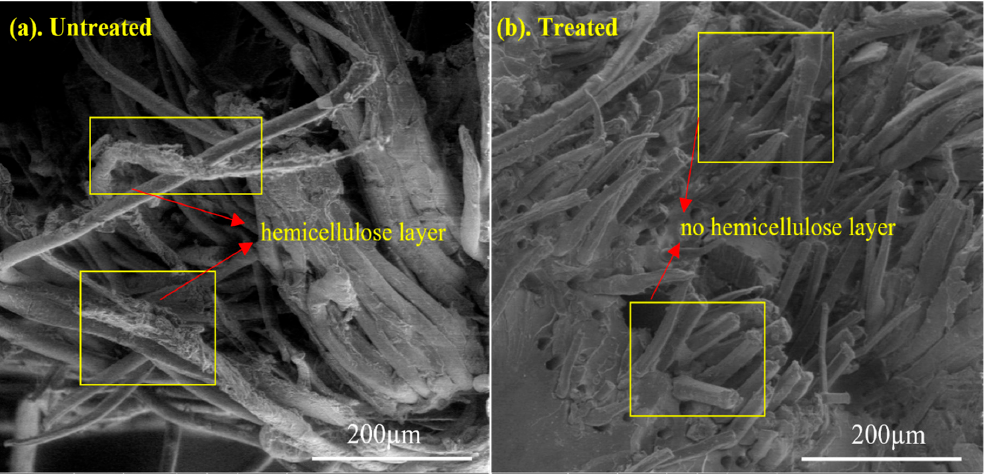
Figure 6. SEM images of tensile fractured ( a ) Untreated ( b ) alkali-treated biotex Flax/PLA reinforced epoxy